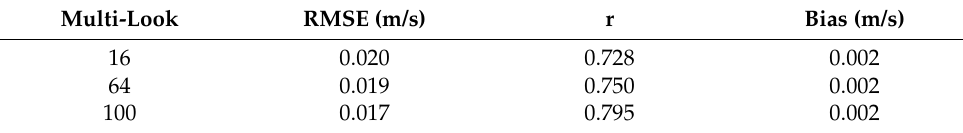
Figure 16. The estimation velocity of ocean surface currents under the different multi-looks from ( a – c ): ( a ) 16 looks, ( b ) 64 looks, and ( c ) 100 looks. The scatter density map between the estimation velocity of ocean surface currents and the control group velocity of the input ocean surface currents under the different multi-looks from ( d – f ): ( d ) 16 looks, ( e ) 64 looks, and ( f ) 100 looks. Table 10. Statistics of the estimation results under different multi-looks.